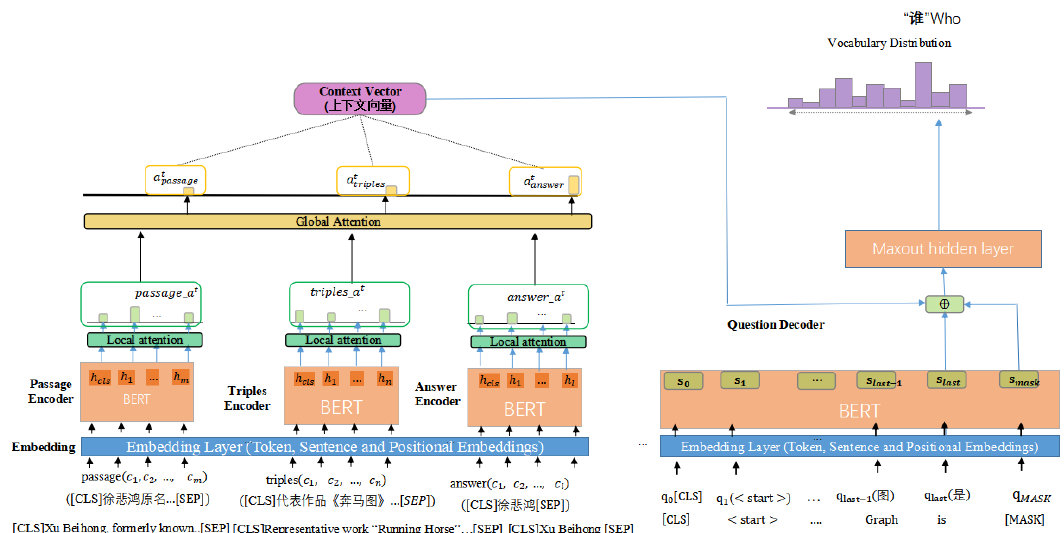
Figure 2. Multiple encoder sequence-to-sequence neural question generation augmented with triples from knowledge graph.